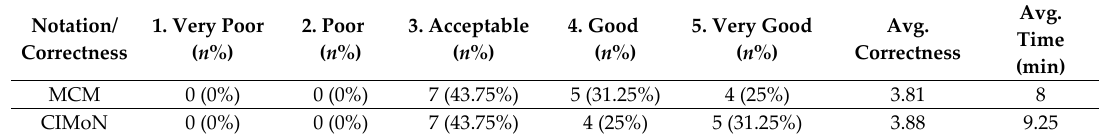
Table 8. Exercise